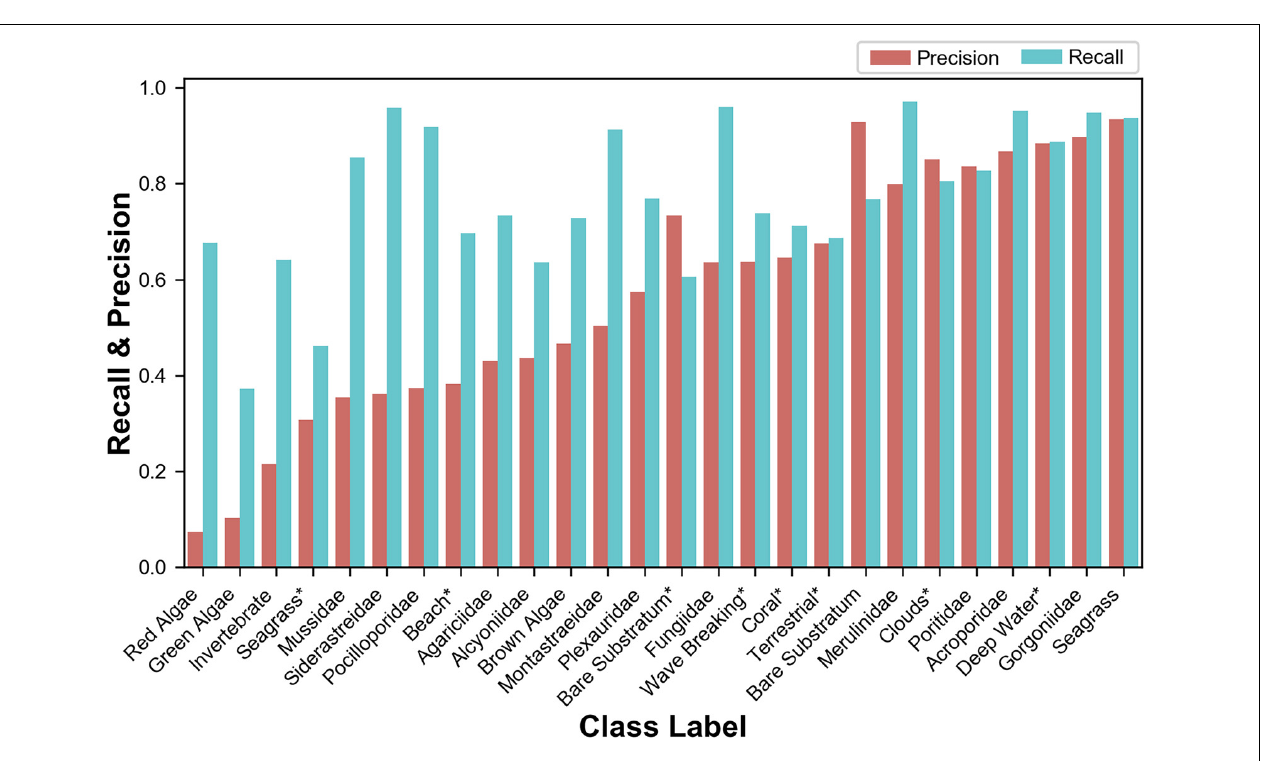
Frontiers in Marine Science |